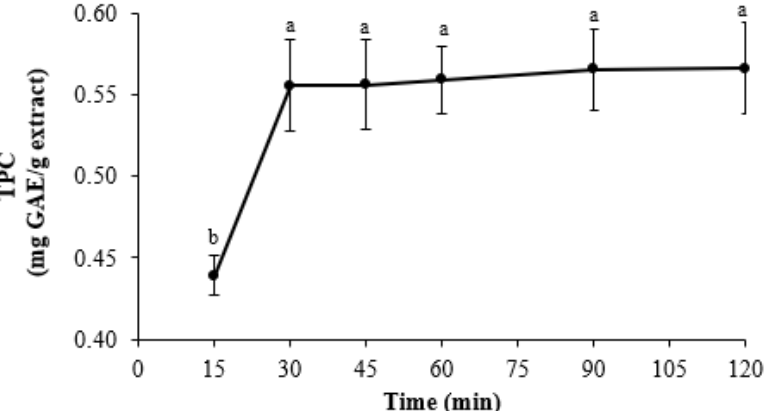
Figure 2. Total phenolic content (mg GAE/g extract) in the RBP extract at different extraction times. Different letters indicate significant differences ( p ≤ 0.05).